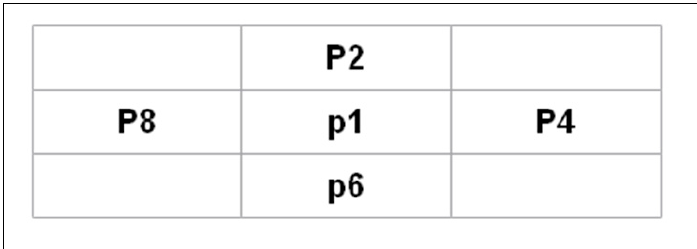
Figure 5. Locations of points that satisfy the conditions.